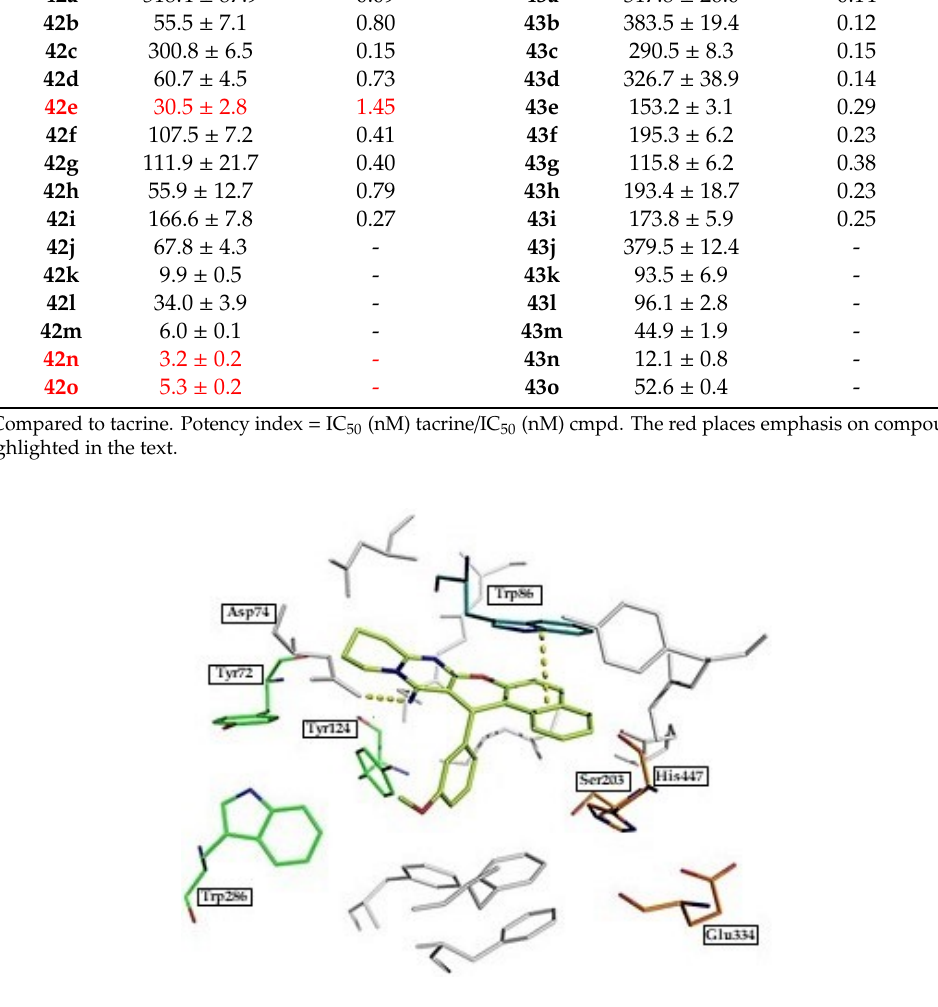
Figure 8. Molecular modeling of ( S )- 42n with h AChE showing the interaction with the mid-gorge region (adapted from [96], © 2016 WILEY-VCH Verlag GmbH & Co. KGaA, Weinheim). Key interactions noted are the π - π stacking between Trp86 and the benzochromeno moiety and an H-bond between Asp74 and the imino moiety.